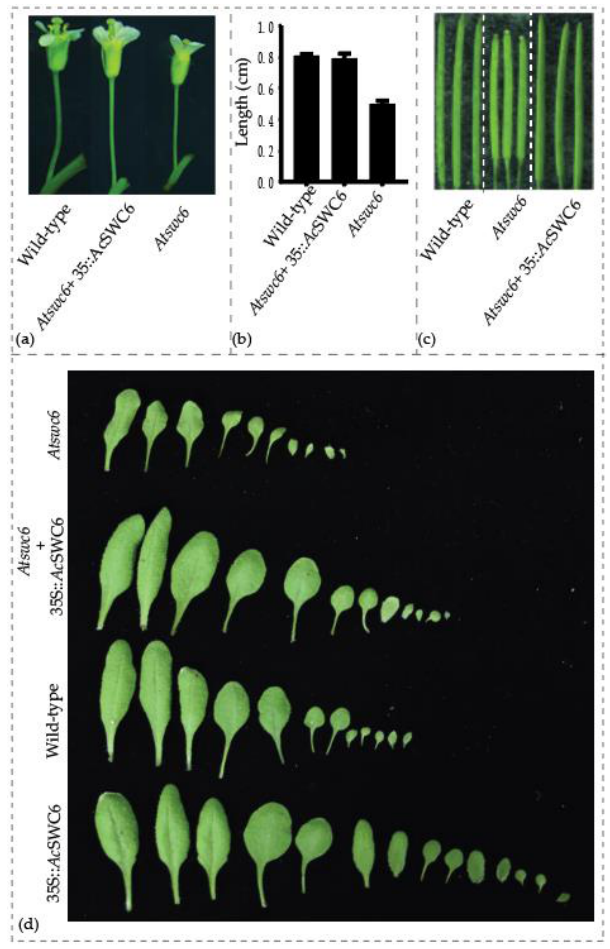
Figure 10. Ac SWC6 flower phenotype in Arabidopsis . ( a ) and ( b ) Pedicel length phenotype, ( c ) Silique and, ( d ) leaf phenotype of wild type, Atswc6 , and Atswc6 35S:: Ac SWC6 complemented lines.